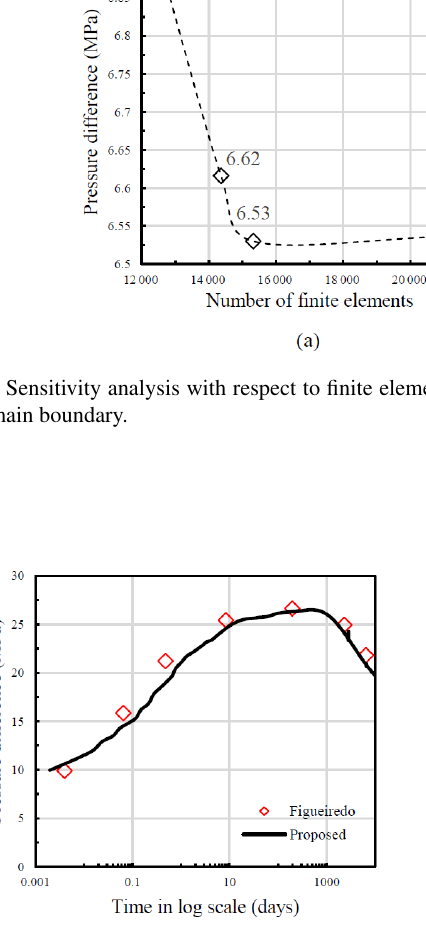
Figure 7. Pore pressure difference with time for the two numeri- cal simulators, i.e. current THM model implemented in COMSOL Multiphysics and Figueiredo et al. (2020) using